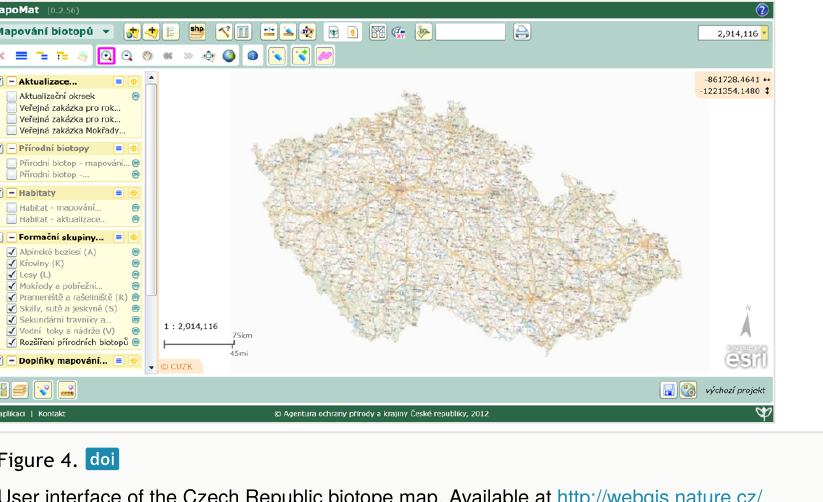
User interface of the Czech Republic biotope map. Available at